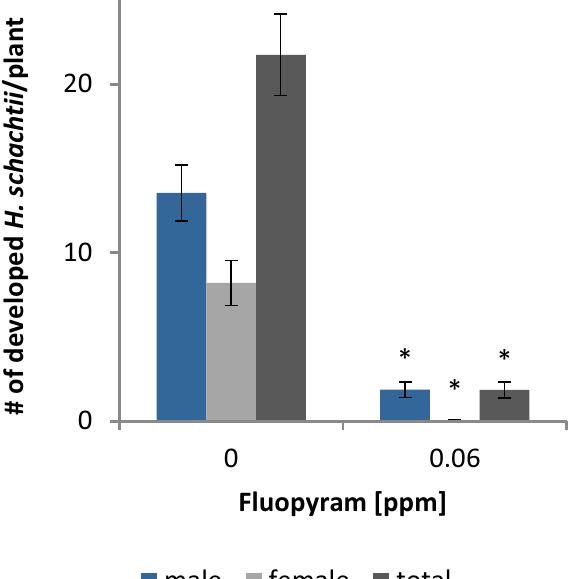
Figure 3. Fluopyram in the plant growth medium efficiently protects plants from Heterodera schachtii . Arabidopsis thaliana was grown on fluopyram- or DMSO-containing agar medium. Plants were inoculated with H. schachtii J2 and the number of adult males and females was determined. Bars display mean ± SE of three independent biological replicates (n = 33–38). Asterisks indicate significant differences to DMSO control according to Dunn’s method ( p <